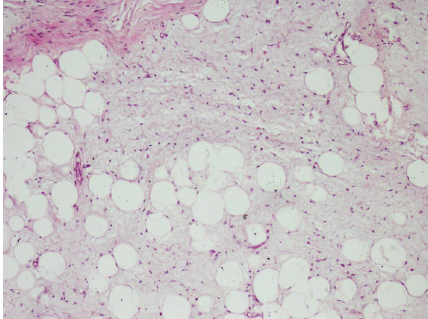
Figure 4: A close-up view of a myxoid area containing adipocytes and spindle cells (H&E ×